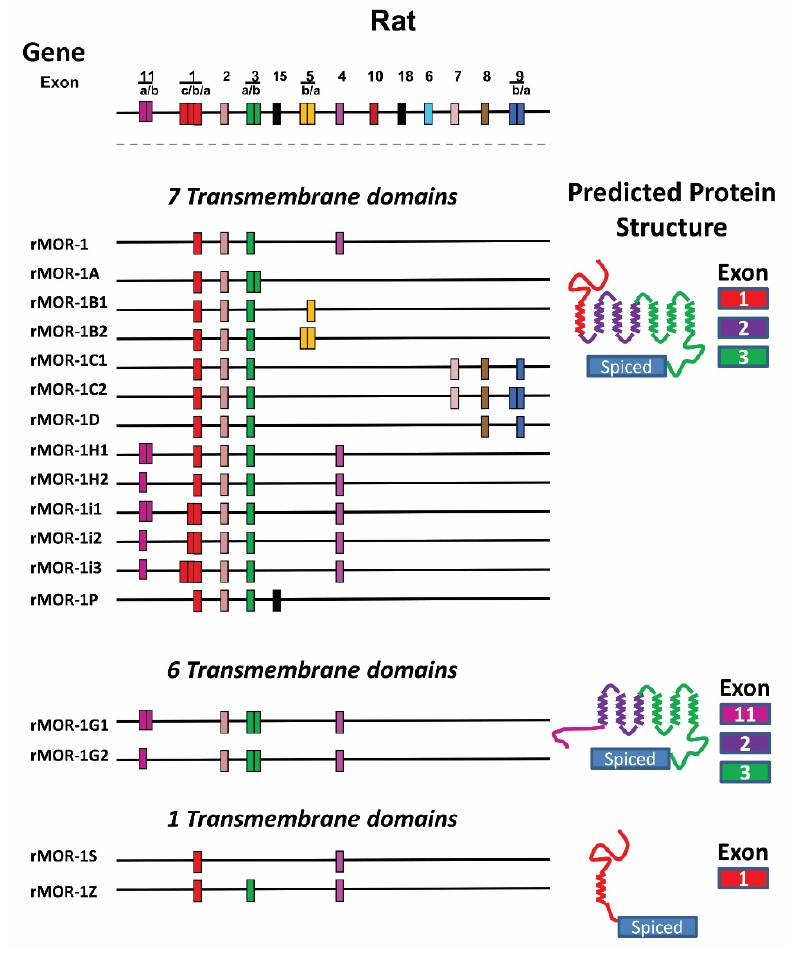
Figure 3. Schematic of the rat Oprm1 gene structure and alternative splicing. The top panel is the Oprm1 gene structure. Alternatively spliced variants reported in the literature are grouped as 7TM, 6TM, and 1TM with predicted protein structure shown to the right and exon color coded to match the splicing schematic. From Pasternak and Pan 2013 [12] .